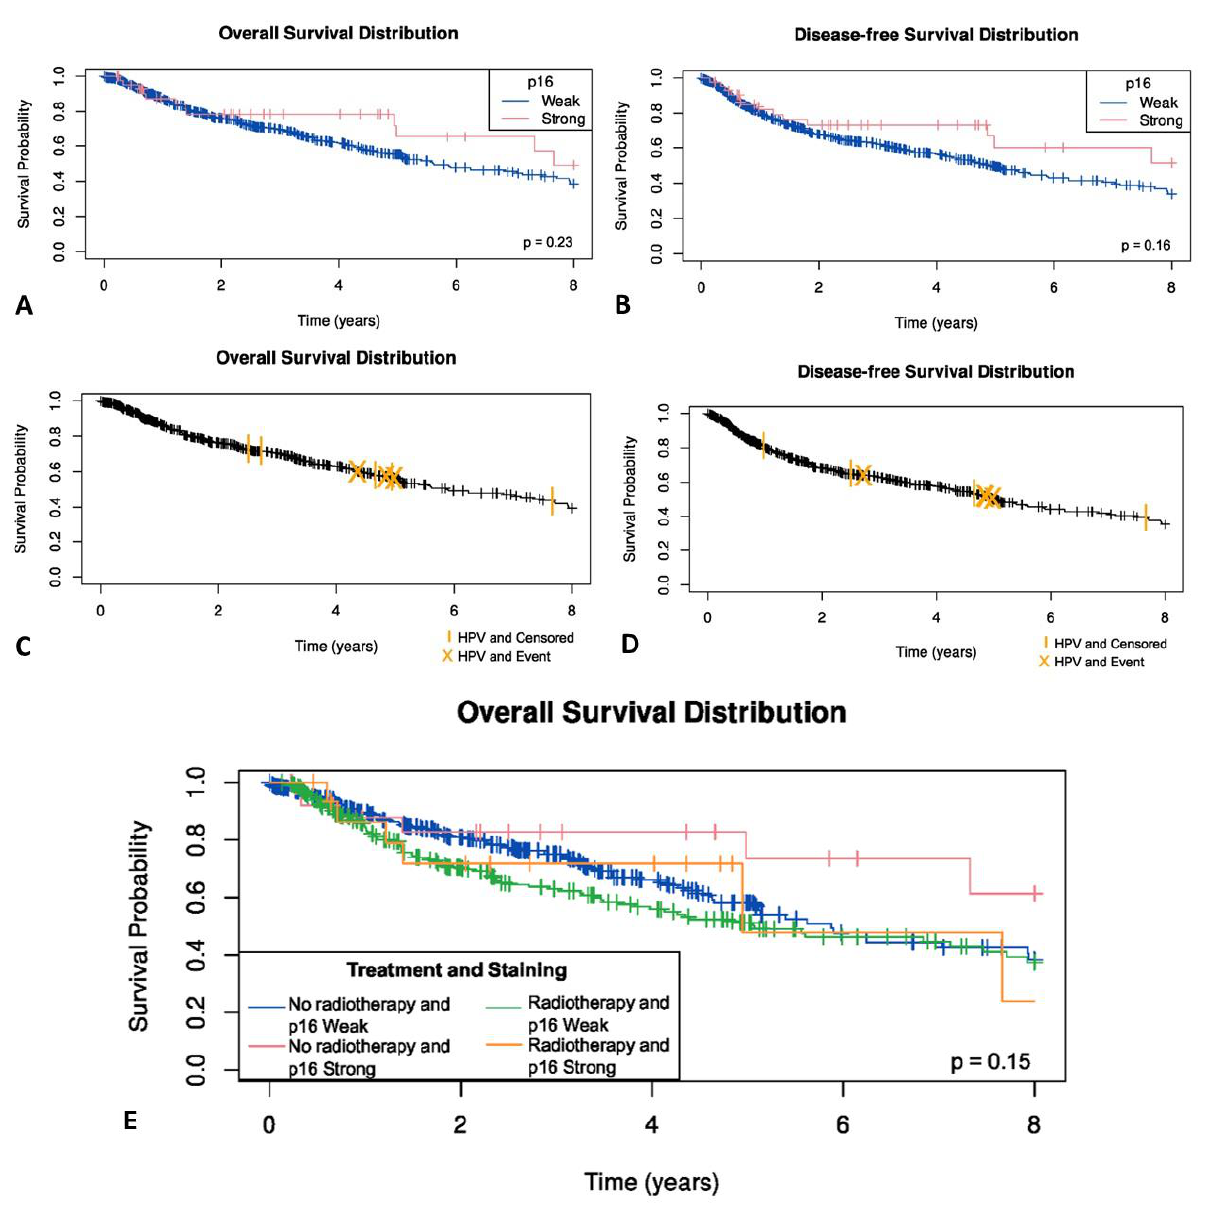
Figure 6. ( A ) Overall survival in OSCC by p16 status; ( B ) disease free survival by p16 status; ( C ) Overall survival in OSCC by HPV status; ( D ) disease free survival by HPV status; ( E ) Kaplan – Meier survival curves by radiotherapy and p16 status in OSCC patients.